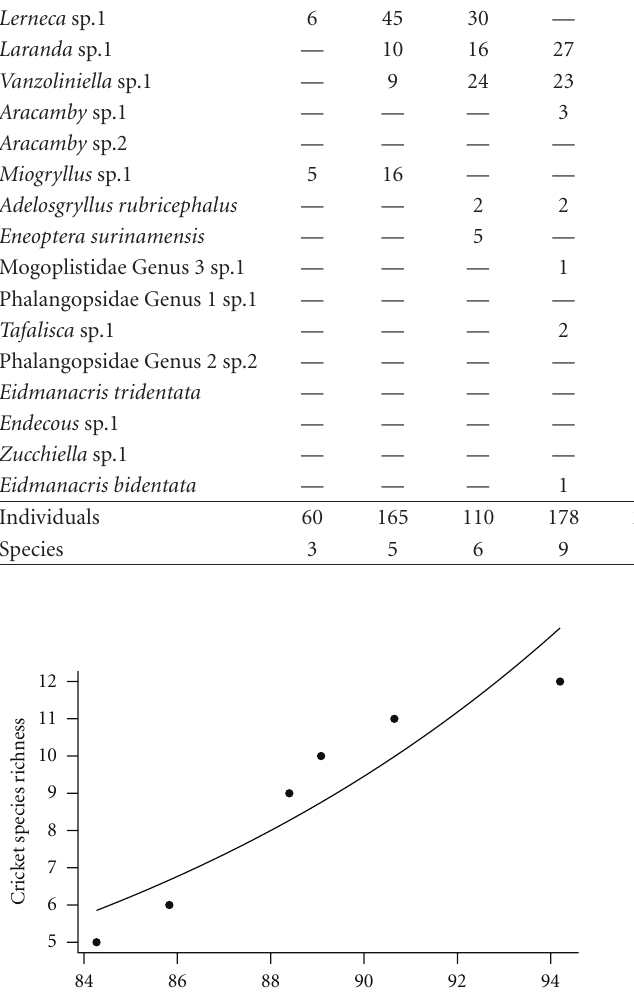
Figure 4: Response of cricket species richness to litter depth. Species richness increased linearly with liter depth. Linear regres- sion with Poisson’s errors: y = e (0 . 894+0 . 328 ∗ x ) ; χ 2 = 8.15; P = 0 . 004. cricket species richness ( χ 2 = 3 . 24; P = 0 . 07 and χ 2 = 0 . 25; P = 0 . 61,